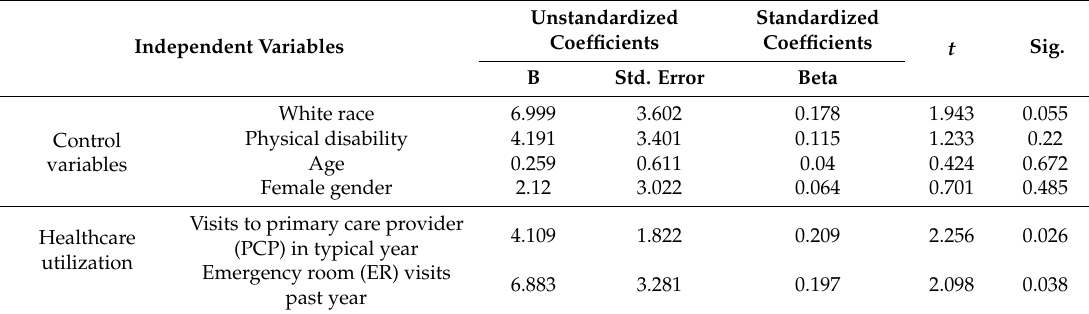
Table 3. Predicting caregiver burden by healthcare utilization (Model R 2 =